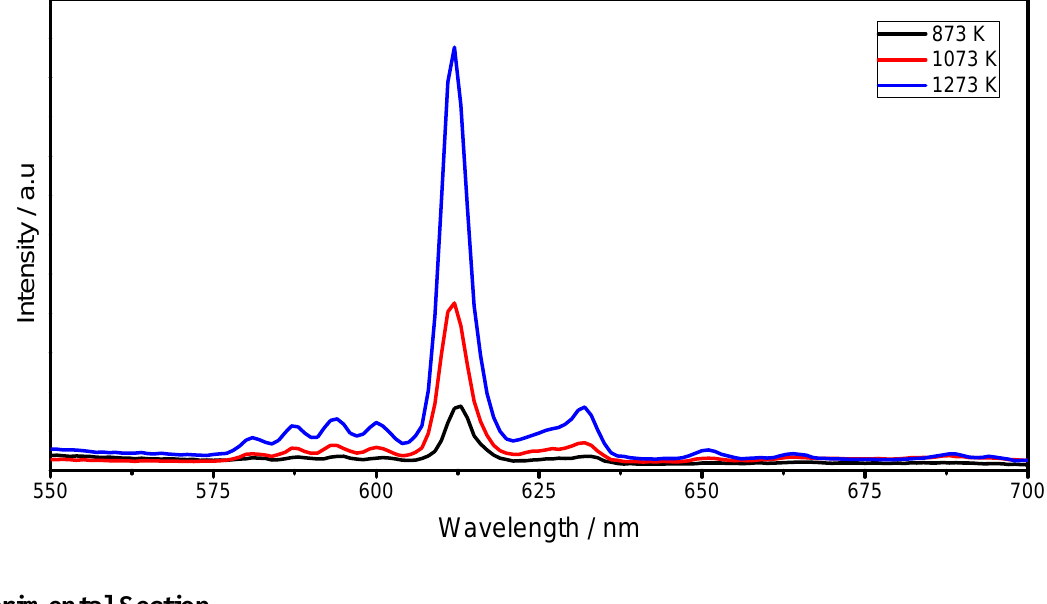
Figure 10. Emission spectra ( λ exc = 254 nm) of Lu F127/Lu = 1.0 level as function of annealing